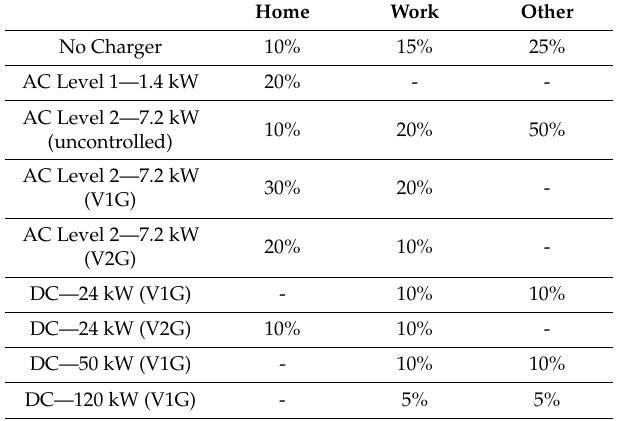
Table 15. Charging Infrastructure Assumptions 2030